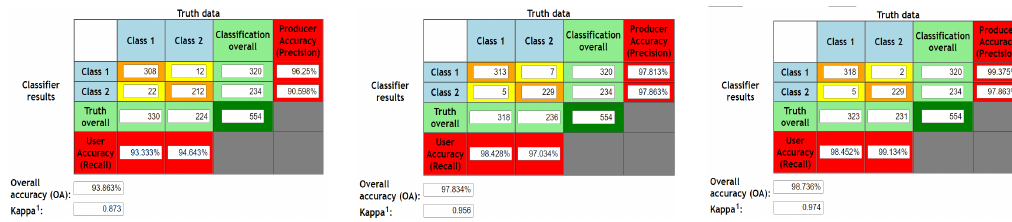
Figure 9. Confusion matrix for 2 fold cross validation of 2D images for SVM, LSTM and VAE-CNN respectively.